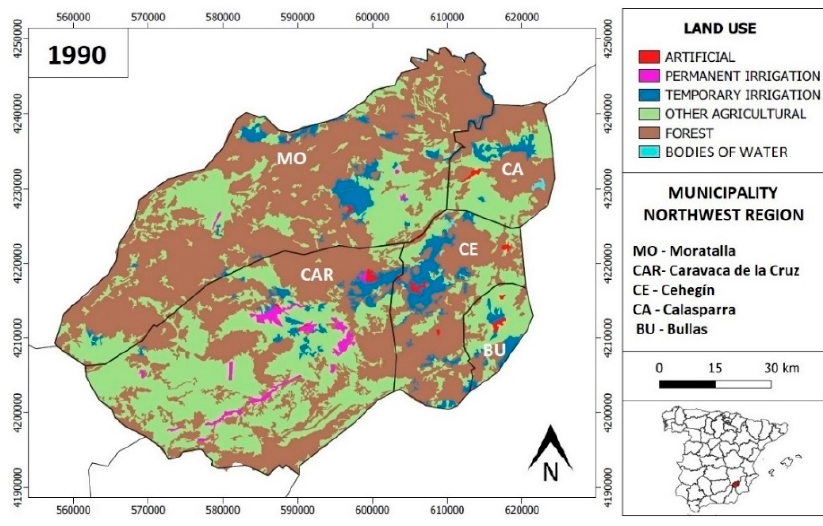
Figure 7. Land use, 1990. Source: Corine Land Cover. Table 4. Distribution of coverage and land use by municipalities